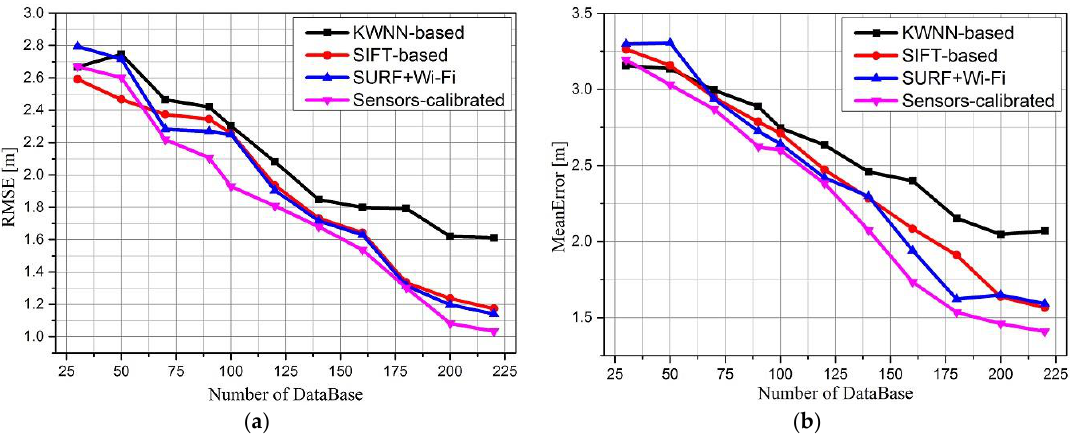
Figure 13. RMSE and mean error comparison of crowd-sourcing with different algorithms.